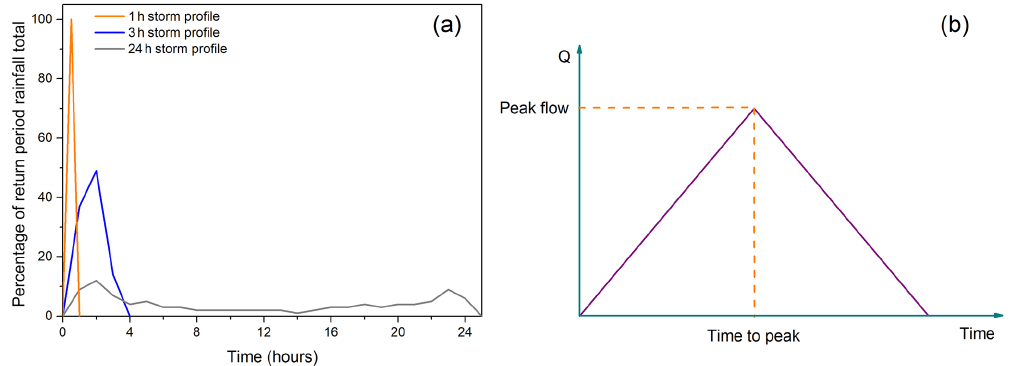
Figure 4. (a) Storm profiles used in current flood modelling; (b) schematic diagram of the river hydrograph